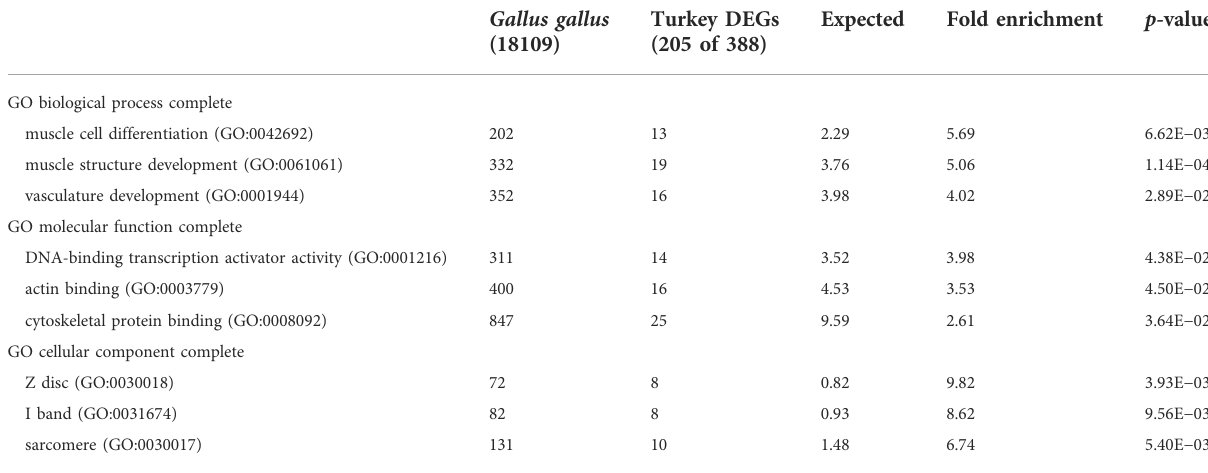
TABLE 7 PANTHER Overrepresentation test of 388 DEGs up regulated in the NCT cells relative to the RBC2 at 43 ° C after 72 h of proliferation. Shown are the gene ontology categories with the greatest fold enrichment in each category a .